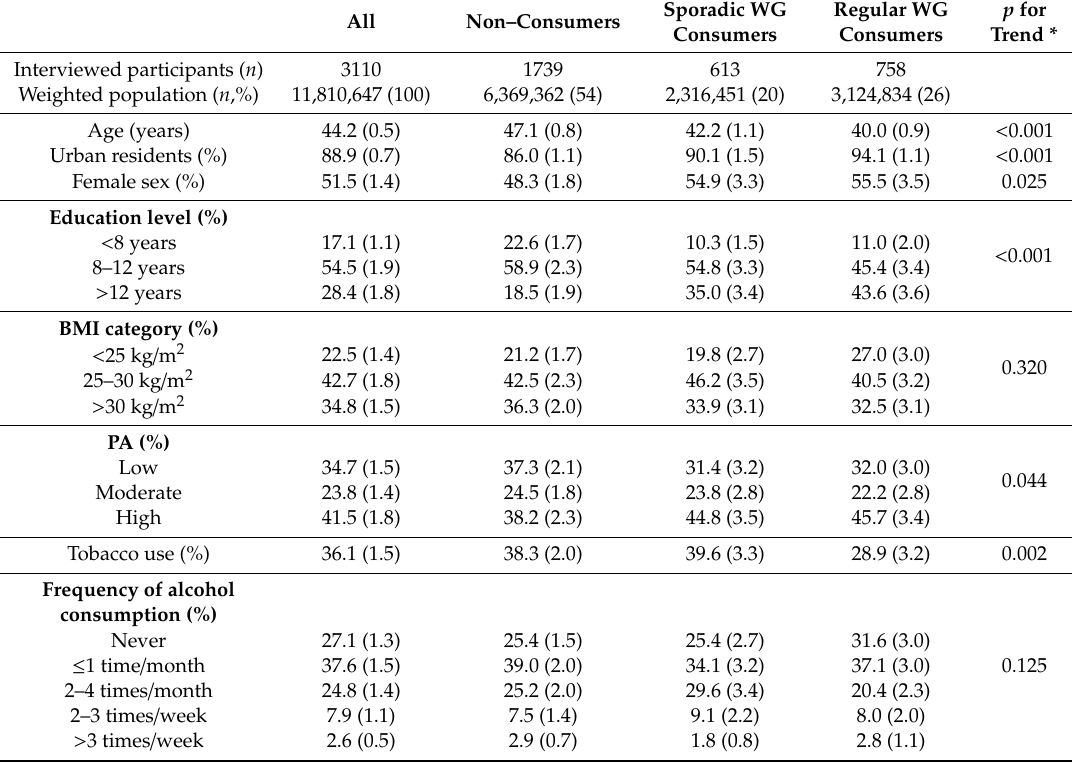
Table 1. General characteristics of the participants according to the frequency of wholegrain (WG)